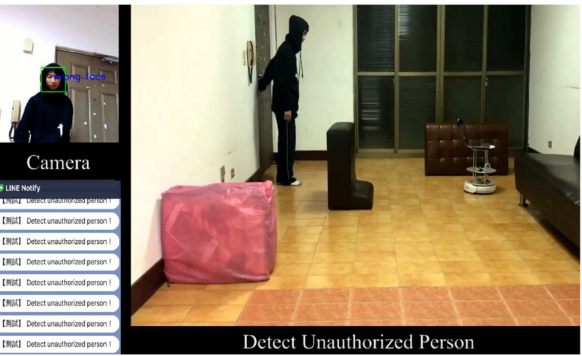
Figure 35. Face recognition of unauthorized person in first indoor environment.